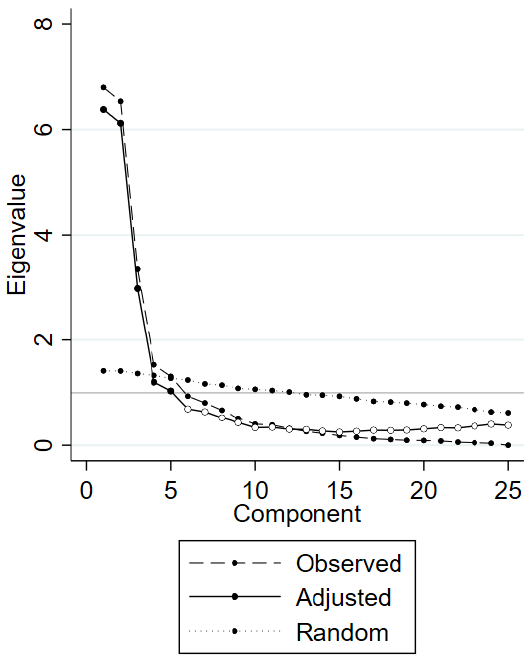
Figure 4. Diagnostic scree plotting graph (performed by parallel analysis) for principal component analysis (PCA) on estimated BWS importance scores data. Table 8. Principal component analysis with oblimin rotation of 25 BWS items.